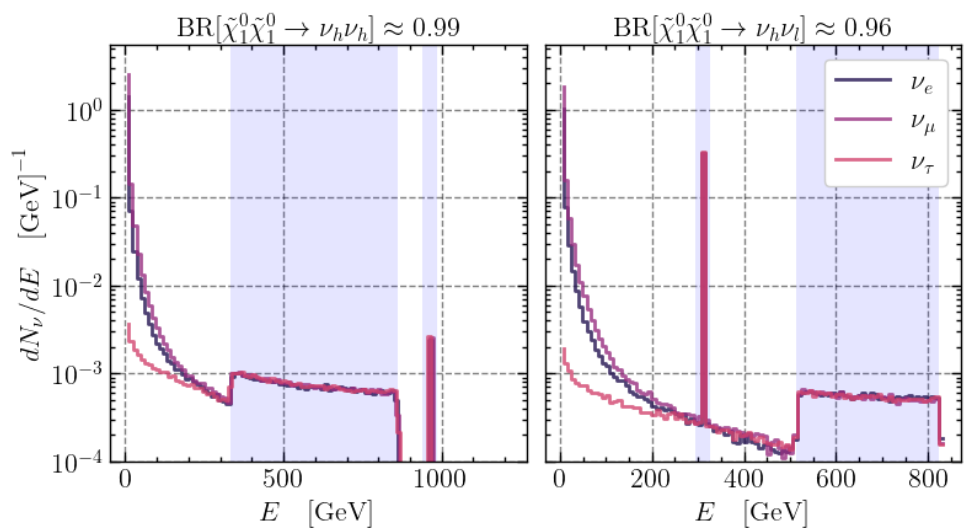
Figure 6: The neutrino spectrum of two main different annihilation channels: χ 0 χ 0 → ν ν χ 0 χ 0 → ν ν (left) and (right). The three different neutrinos ν (cid:101) (cid:101) h h h l 1 (cid:101) 1 1 (cid:101) 1 ν ν µ , τ have been colour coded. All spectra have been computed by MadGraph using 100k events. The predicted peak and plateau regions have been shaded. The width of the shade for the peak region has been widened for